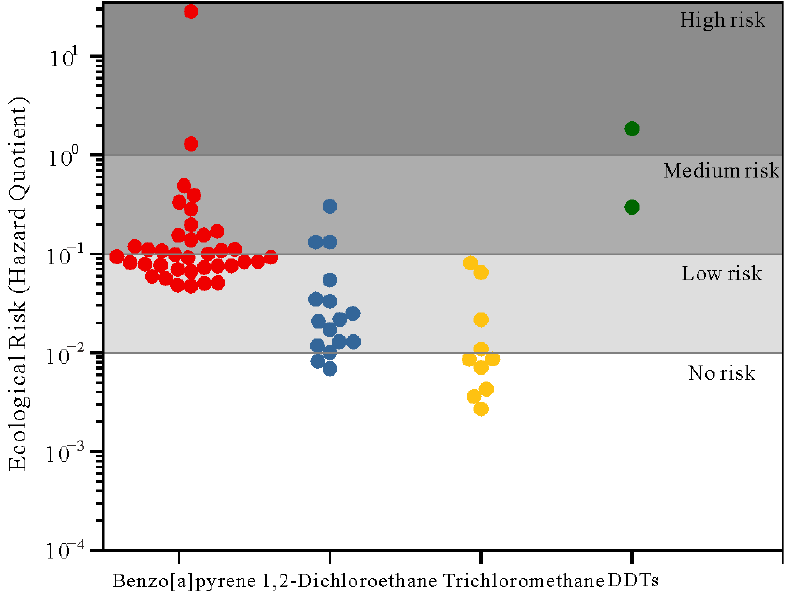
Figure 7. Ecological risk of PCOPs in groundwater.